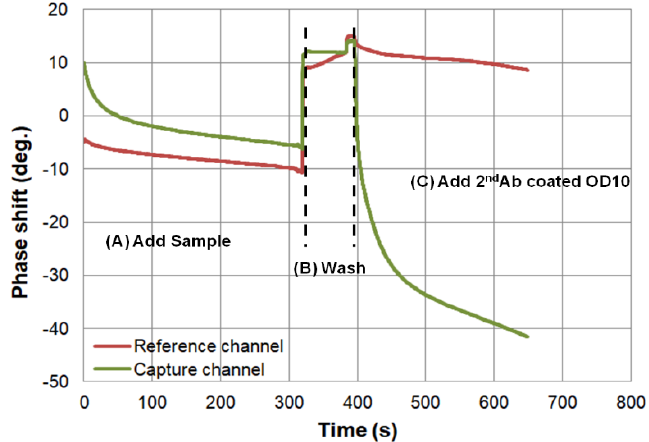
Figure 4. Phase shifts signals of three steps measurement with SH-SAW biosensor. The phase shifts of the SH-SAW biosensor output signals are measured continuously during assay steps (A), (B), and (C). The phase at the end of the step (B) was set as the baseline.